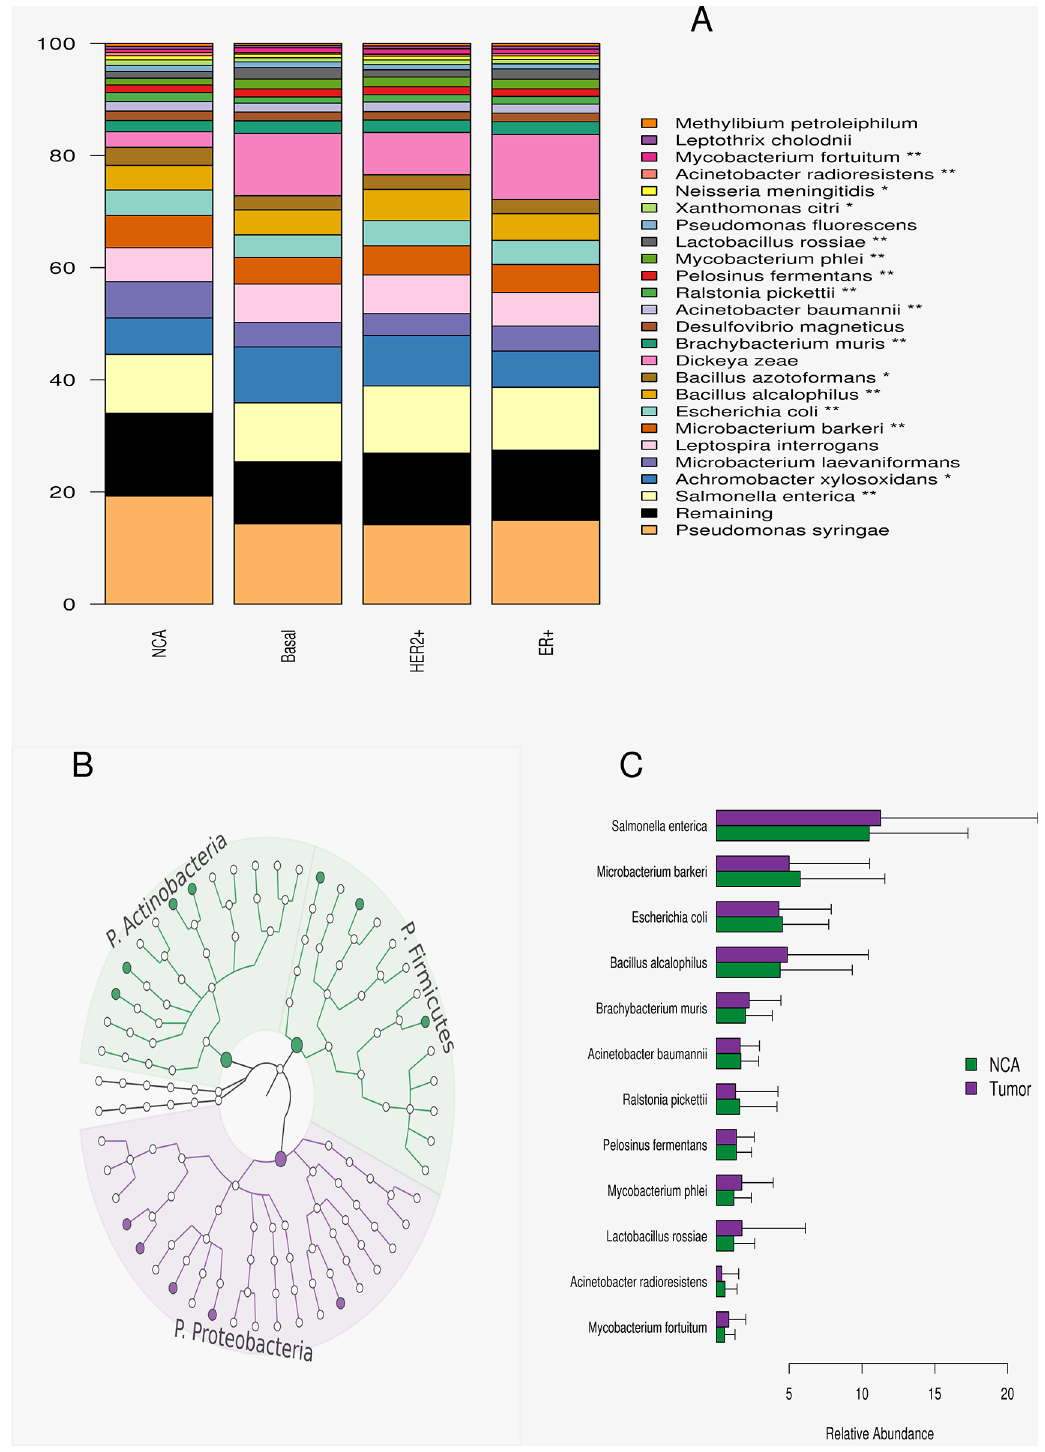
Fig 3. OTU’s significantly different among the breast cancer populations. (A) Twenty-four species were observed to have averageabundance between0.5% - 19.3% amongthe NCA samples. These speciesare presented as a barplot summary averagedamongeach subtype. (B) A cladogramof the 48 differentiallyabundantspecies, 12 of the 24 prevelent species (averagerelative abundance greater than 0.5%) were observedto be signicantafter Benjaminiand Hochbergcorrection for mutiple testing error. (C) The averagerelative abundance and standard deviationof the 12